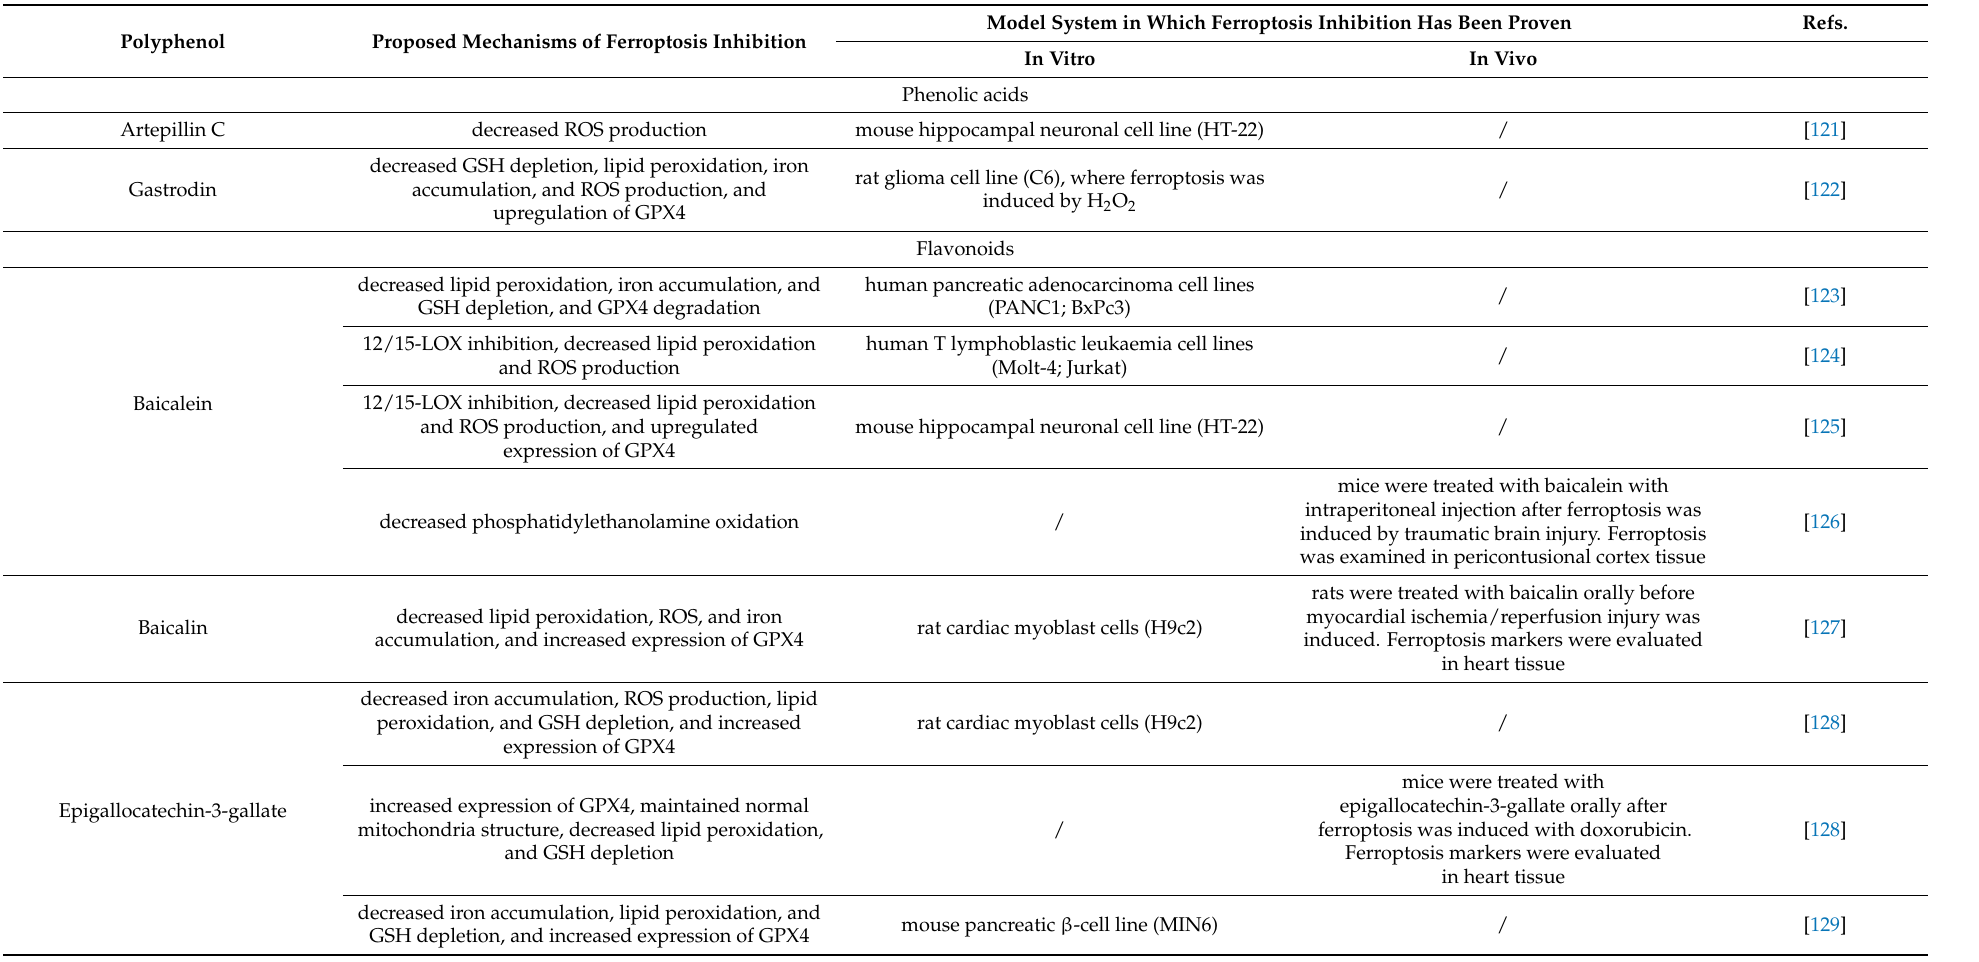
Table 1. PCs as potent inhibitors of ferroptosis, proposed mechanisms for ferroptosis inhibition, and model systems where ferroptosis inhibition has been